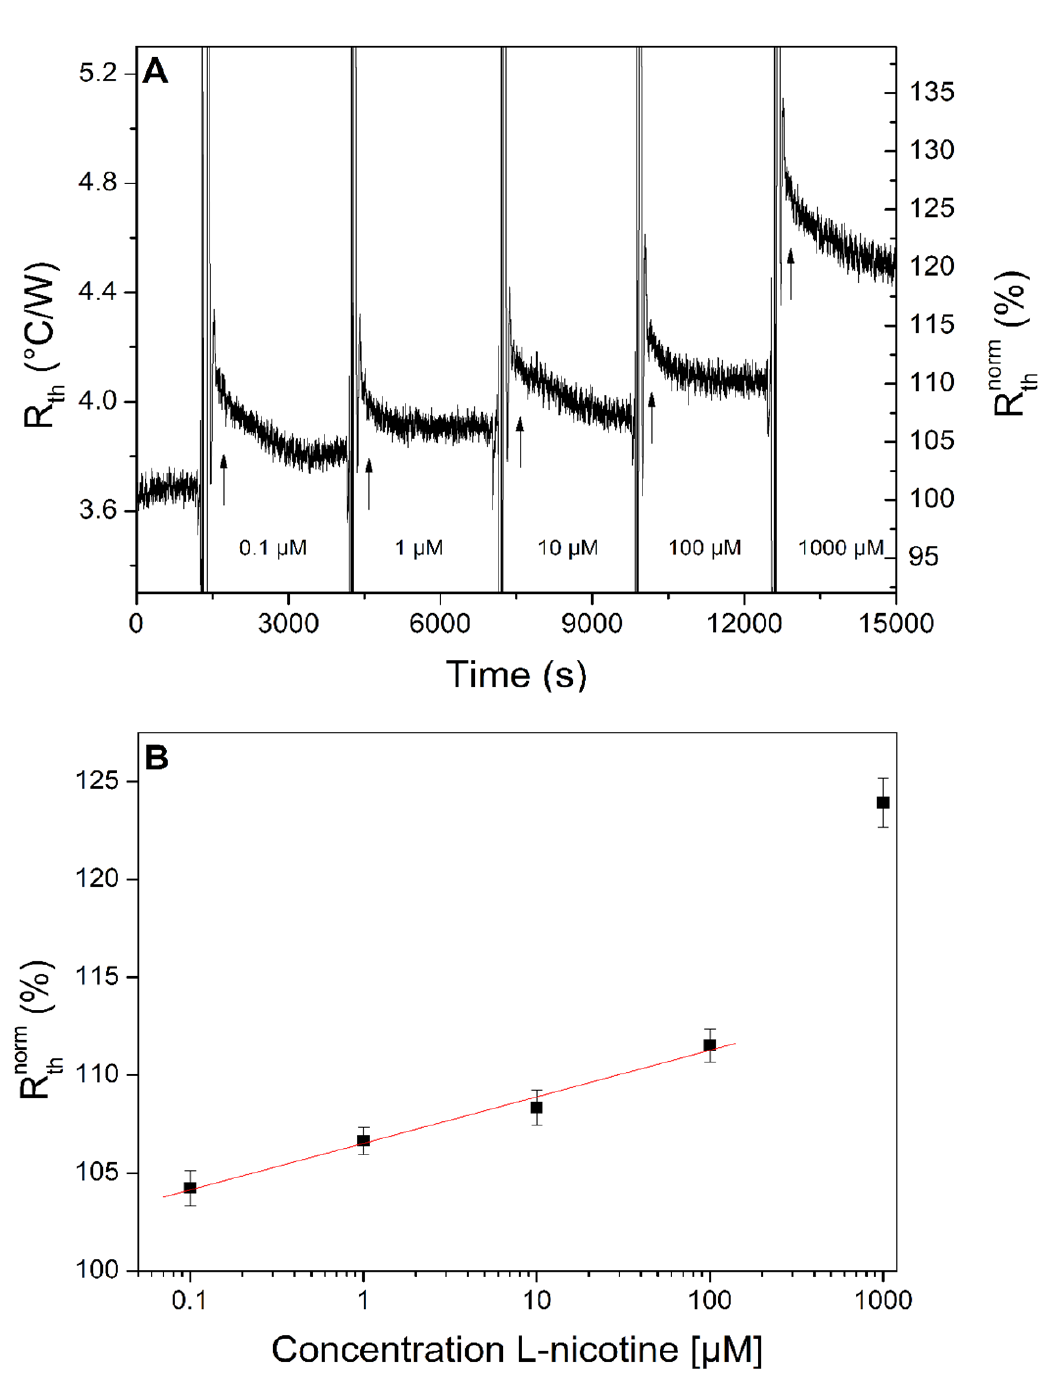
Figure 5. ( A ) shows the raw, unfiltered R data for five solutions with an increasing th L-nicotine concentration on a sensor chip covered with MIPs for L -nicotine detection. The right vertical axis displays the normalized data, expressed as a percentage of the initial R th in PBS. ( B ) is the dose-response curve in which the concentration versus the relative response in R is plotted. The data are not corrected for non-specific adsorption th